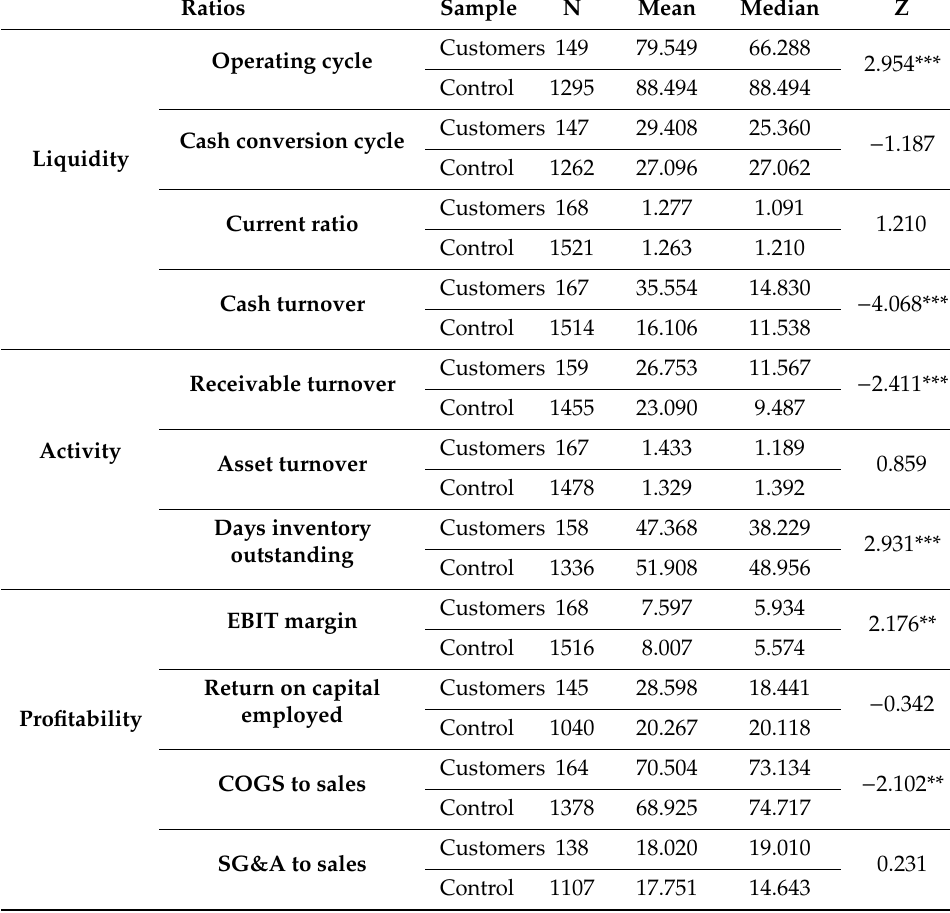
Table 6. Comparison of ratios for customers of SCLs and control firms.